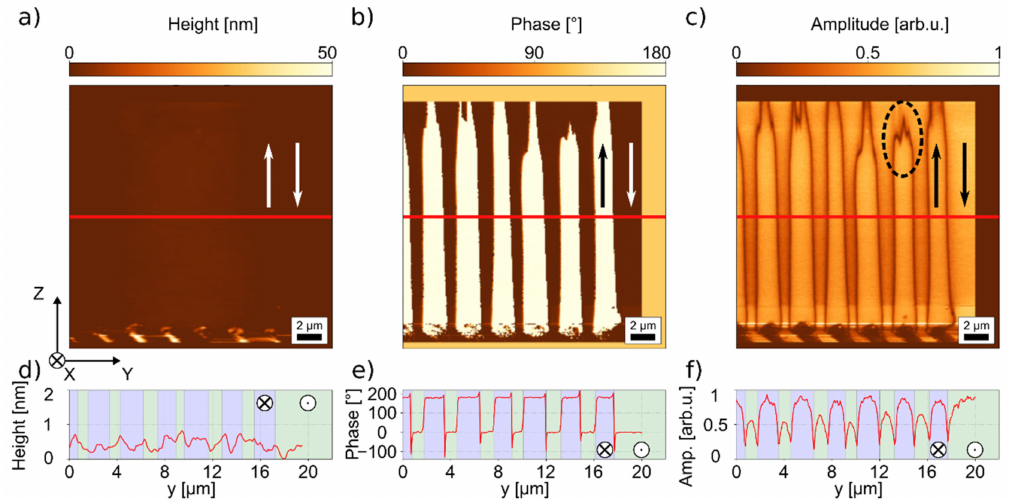
Figure 4. PFM colormaps of ( a ) topography, ( b ) phase, and ( c ) amplitude signal for an x-cut PP-TFLN sample, and ( d – f ) respective line scan graphs taken along the red line in ( a – c ). While the height signal shows no topographical features in poled regions, the phase signal provides domain inversion, while the amplitude signal allows imaging with a superb DW contrast. The circled area in the amplitude map ( c ) might be indicative for an incomplete in-depth domain inversion close to the ( − ) electrode (see text).